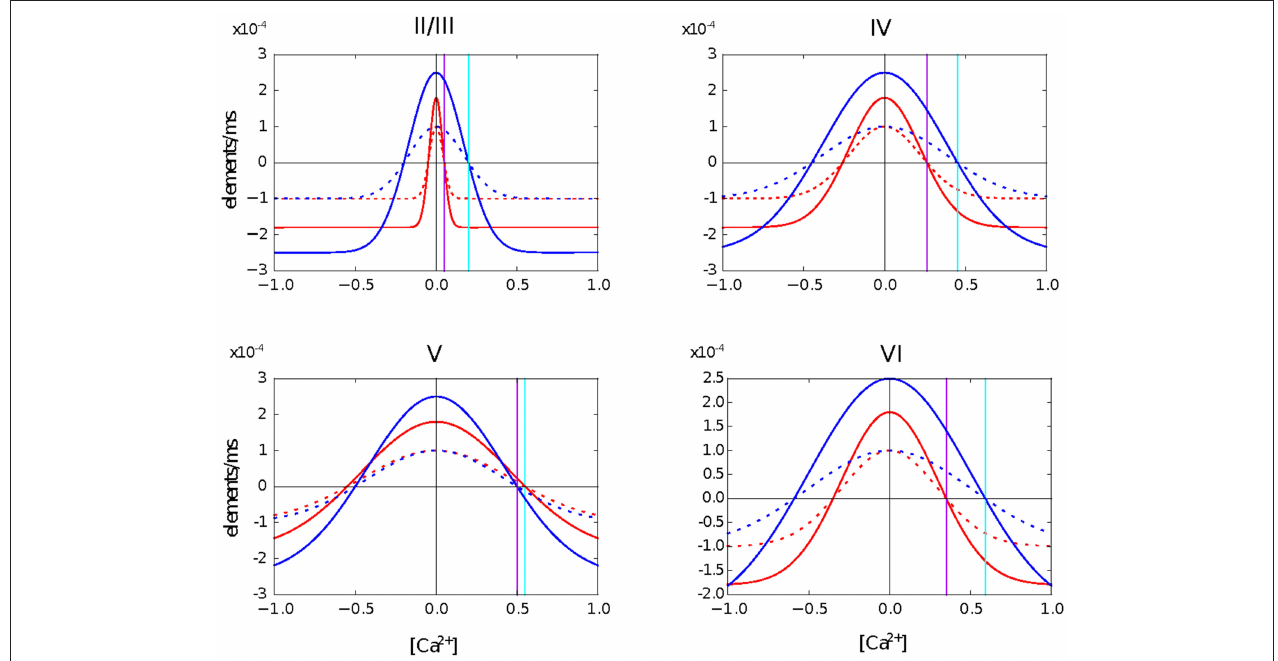
FIGURE 1 | Growth curves for each synaptic element in each layer of the cortical microcircuit model. The growth curves define the rate at which synaptic elements are created depending on the amount of calcium concentration in the cell at the moment. Red curves are for neurons in the excitatory population. Blue curves are for neurons in the inhibitory population. Solid lines are for the excitatory synaptic elements and dotted lines represent inhibitory synaptic elements. The vertical purple line defines the target level of calcium concentration for excitatory neurons and the vertical cyan line represents the target level of calcium concentration for inhibitory neurons. It is important to highlight that all synaptic elements of the same neuron must have a growth curve with the same target level of calcium concentration, otherwise equilibrium will never be reached.